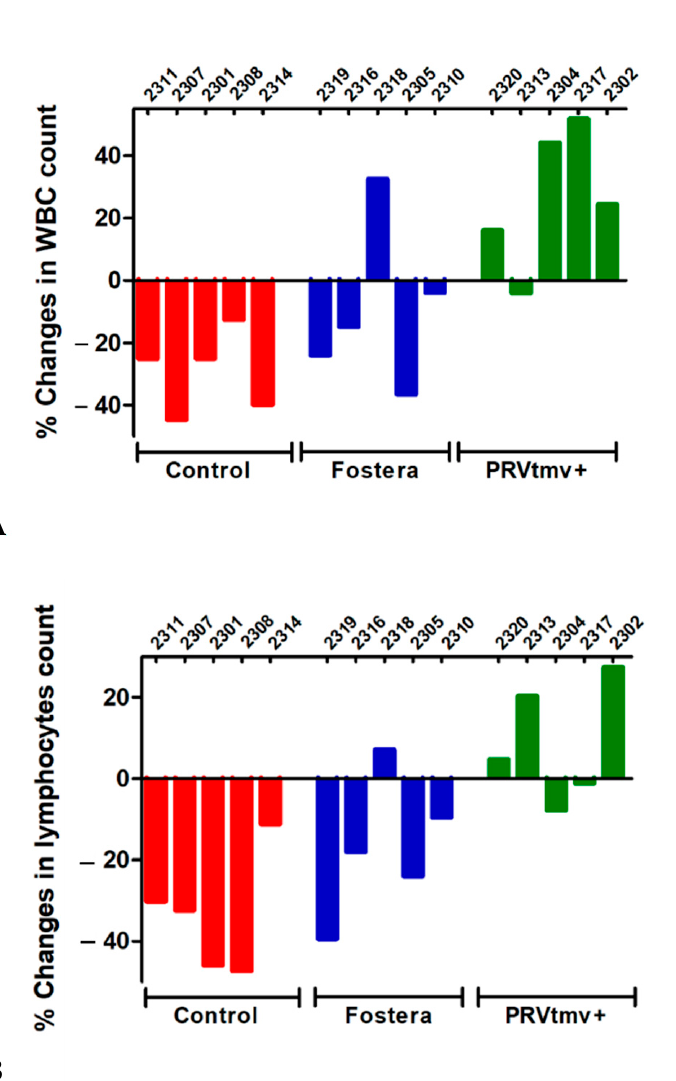
Figure 14. Percent changes in leukocyte and lymphocyte count following challenge in all three groups. Whole blood was collected from pigs on 32 dpv/0 dpc and 53 dpv/21 dpc, and ( A ) leukocyte and ( B ) lymphocyte counts were determined and percent changes were calculated. 3.12. Both PRVtmv+ and Fostera Immunized Pigs Did Not Shed the PCV2b Challenge Virus in Feces Fecal virus shedding is a transmission source of PCV2b virus in pigs [54]. We deter- mined PCV2b shedding by qPCR in fecal swabs on 0, 13, 17, and 21 dpc. Low fecal PCV2b shedding levels were observed only in a few control group pigs on 17 and 21 dpc; PCV2 genome copy numbers ranged between 13–35 copies/200 ng of total DNA in two pigs on 17 dpc and one pig on 21 dpc (Figure 15; Supplementary Table S7). No PCV2b genomic DNA was detected in the fecal swabs of PRVtmv+ and Fostera-vaccinated groups after the PCV2b challenge through the day of euthanasia (21 dpc). Regardless of the experimental group, neither PCV2b infectious virus nor genomic DNA was detectable in the nasal and tonsil swabs after the